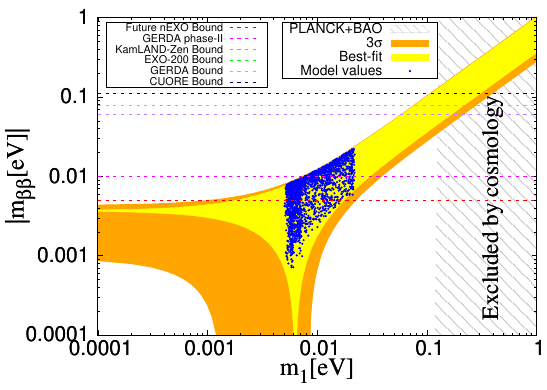
Figure 3 . | m ββ | as a function of m 1 . The vertical gray dashed region indicates the upper limit on the sum of the three light neutrino masses from Planck+BAO